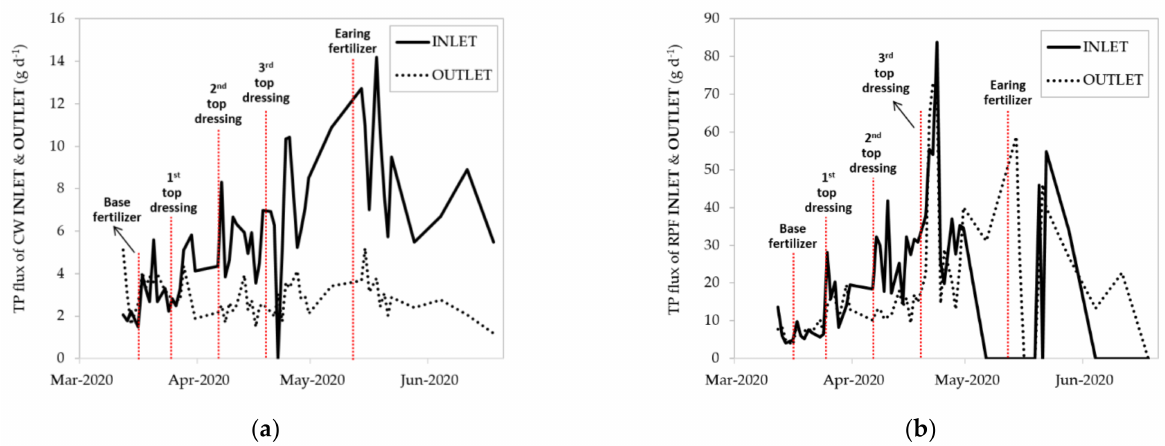
Figure 6. Total phosphorous fluxes of INLET and OUTLET in ( a ) CW treatment and ( b ) RPF treatment of the first crop season, 2020 (March–June); each fertilization timing is marked. Table 6. The average total phosphorus fluxes and removal efficiency of each fertilization period. Fertilization